Question: Briefly state, in one sentence, what is plotted here.
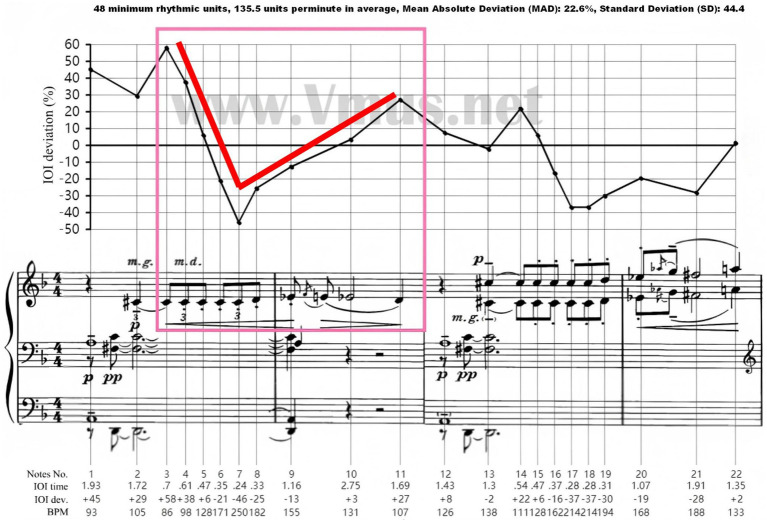
Answer: Krystian Zimerman “Viewing one of the jars” theme IOI deviation curve.